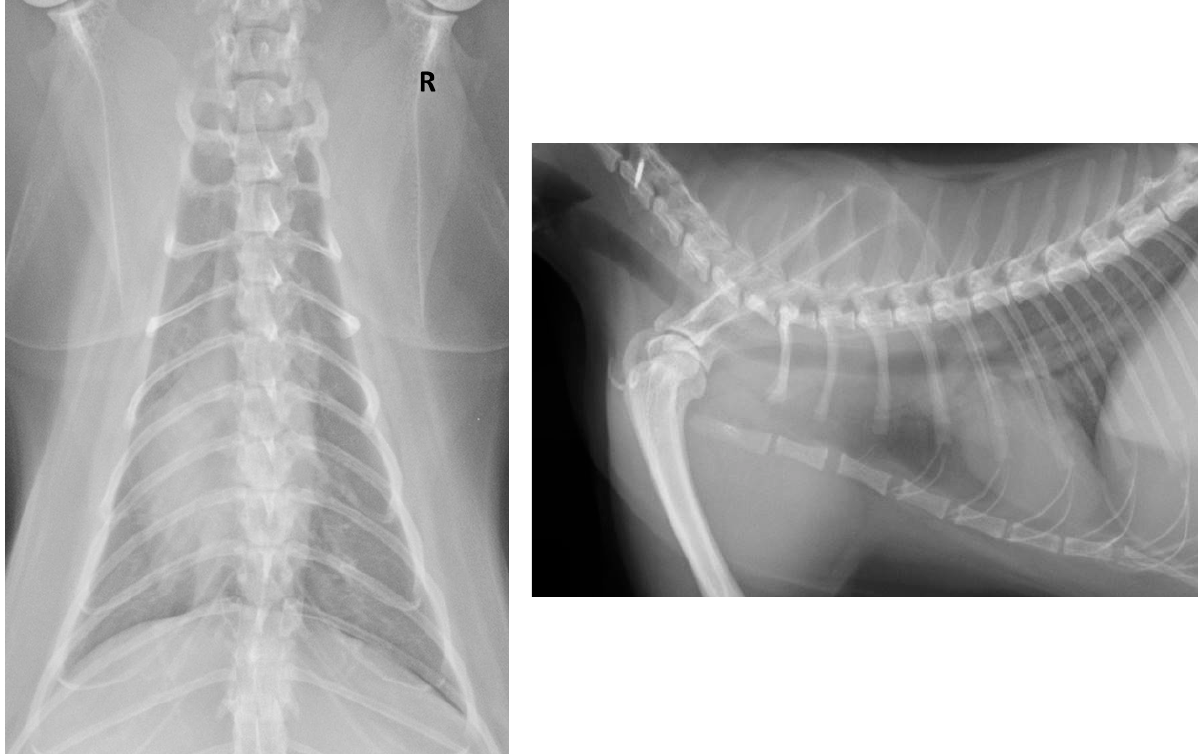
Figure 2. Thoracic radiographic study on Day 14: dorsoventral (DV) and right lateral radiographies (RL). The radiologic findings show a mild-to-severe diffuse bronchial pattern and a mild diffuse interstitial lung pattern. R = right side